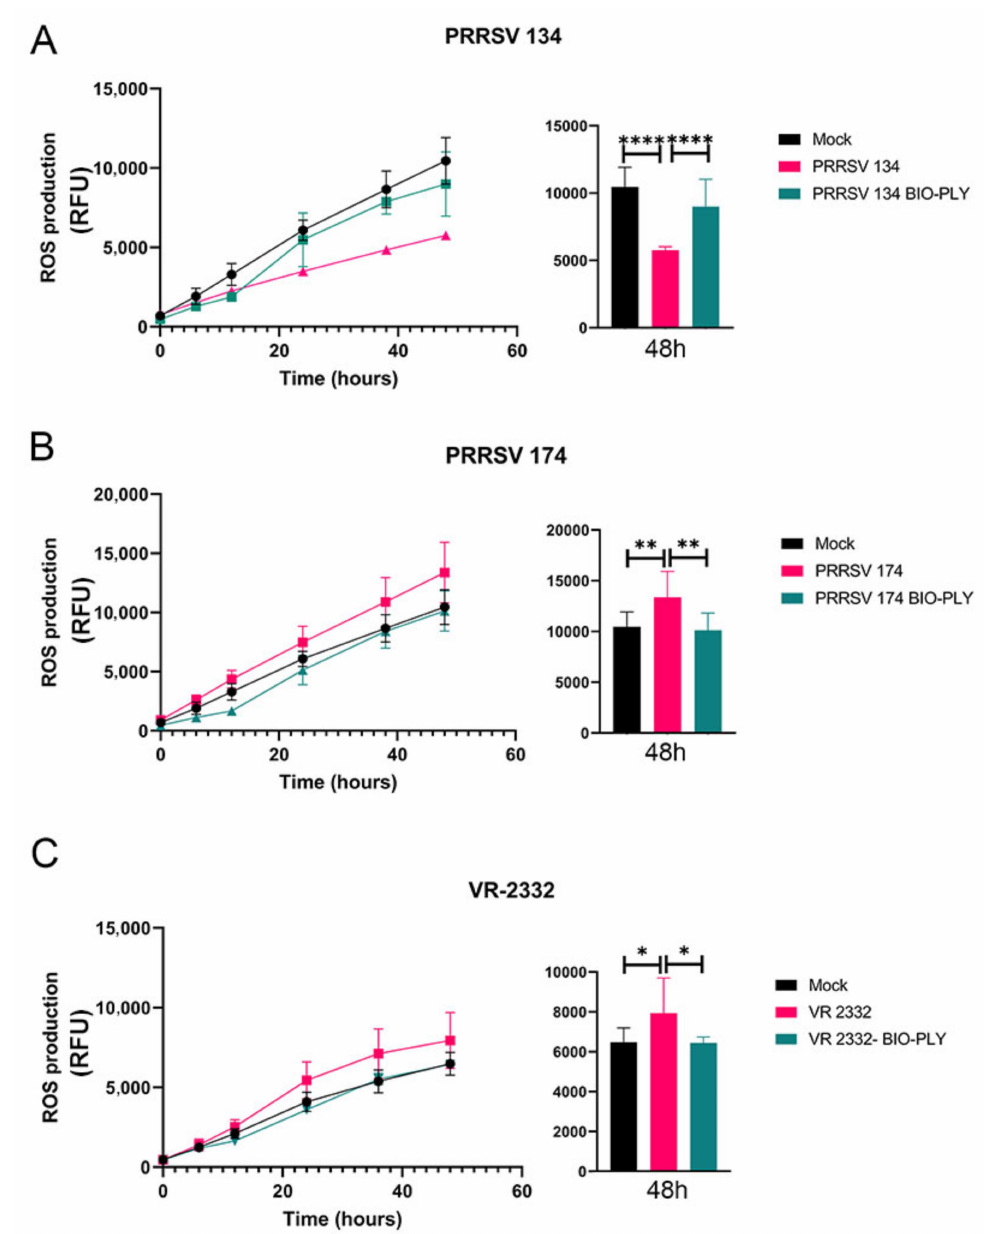
Figure 6. Effect of BIO-PLY TM treatment on the ROS production of porcine alveolar macrophages (PAM) infected with PRRSV-2. Briefly, cells were infected with ( A ) PRRSV NC-134, ( B ) PRRSV NC-174, or ( C ) PRRSV VR-2332, or left in culture alone (mock). ROS production was measured at different time points (left) and visualized at 48 h (right). All experiments were performed using technical duplicates in 4 biological replicates. Obtained values were normalized to the average of the mocks. Results were analyzed via ANOVA and displayed showing means and standard error of mean (SEM). p -values were expressed using asterisks following APA and Prism standards. * p ≤ 0.05, ** p ≤ 0.01, **** p ≤